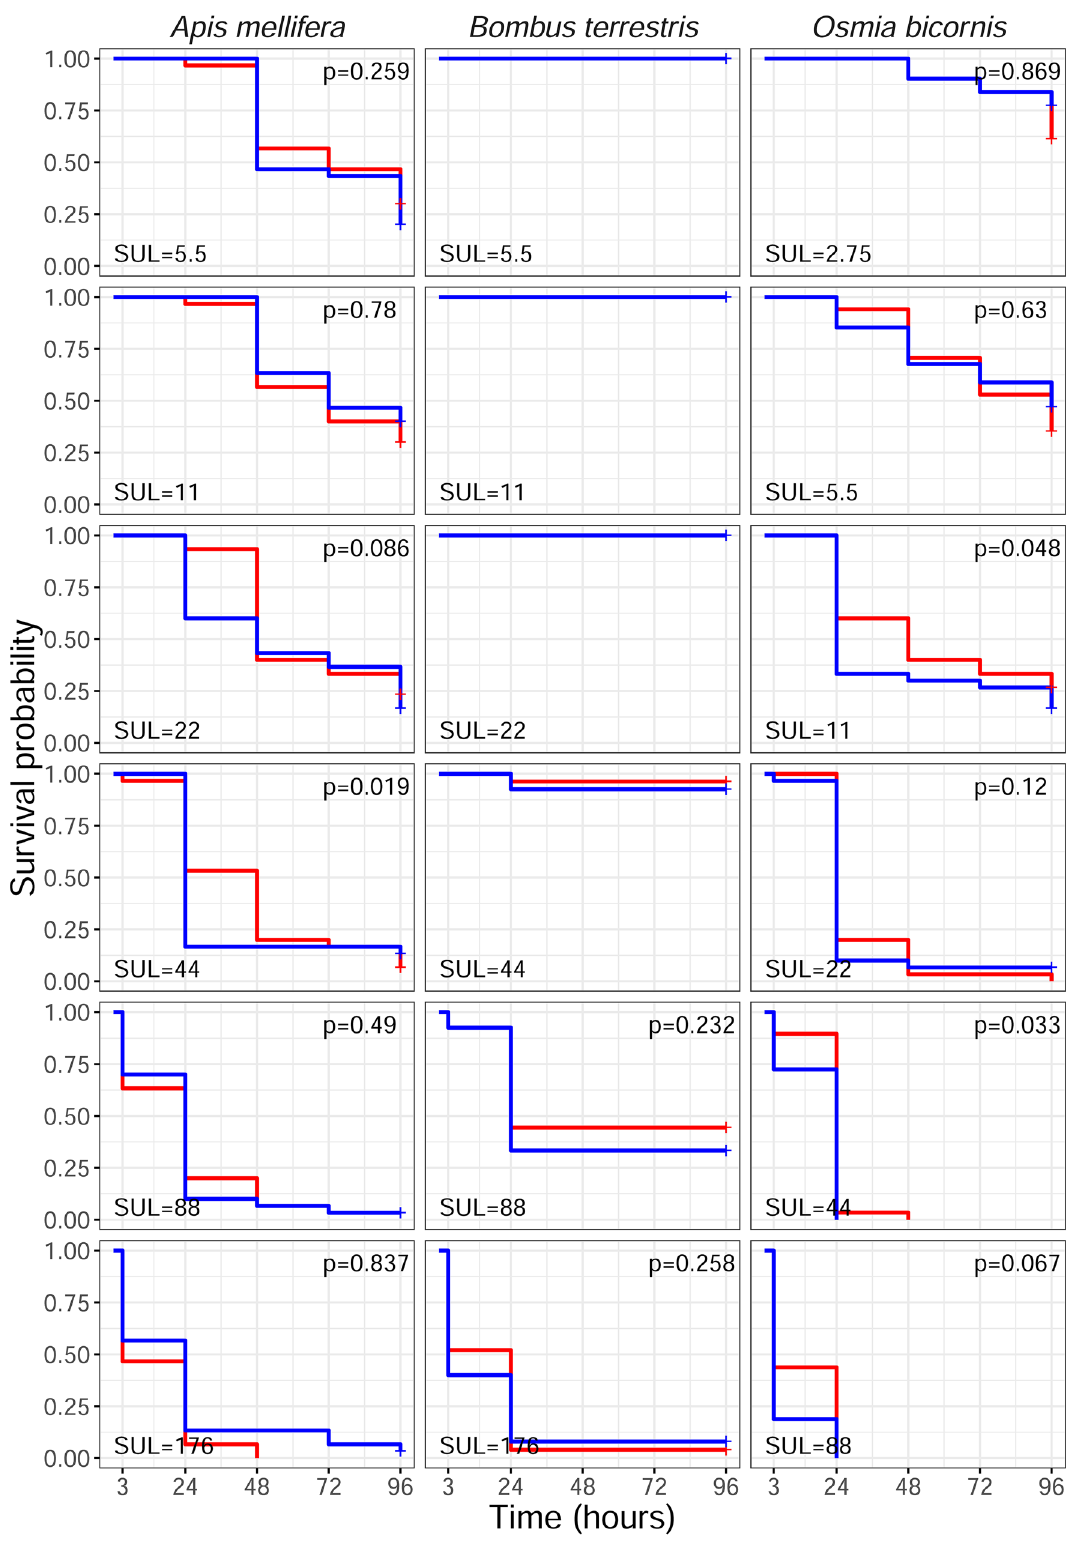
Figure 1. Observed (blue lines) and expected (red lines) effects of various doses (in ng bee −1 ) of sulfoxaflor (SUL) (y-axis) in combination with a single dose of fluxapyrozad (FLU) (1.2 µg/bee) on survival probability in three bee species. Significant synergism based on Bliss criterion of drugs independence (P <